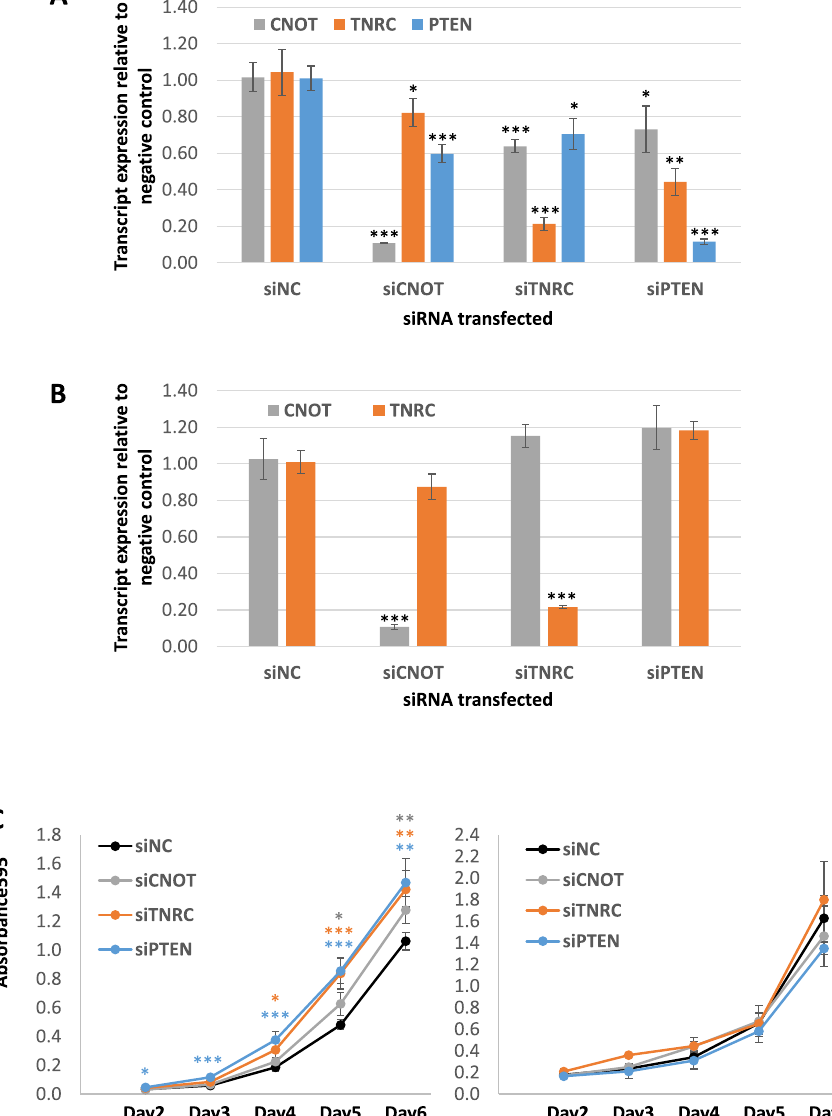
Figure 6. Crosstalk between PTEN and PTEN ceRNAs is reciprocal. ( A , B ) Real-time PCR analyses of changes in transcript expression of PTEN and PTEN ceRNAs after transfection with siRNA against TNRC6B, CNOT6L and PTEN relative to the non-targeting control in DU145 ( A ) and PC3 ( B ) cells. ( C ) Proliferation curve of DU145 (left) and PC3 (right) transfected with siRNAs against TNRC6B and PTEN. siPTEN and siTNRC6B result in a significant increase in growth relative to the siNC control in DU145 but not in PC3